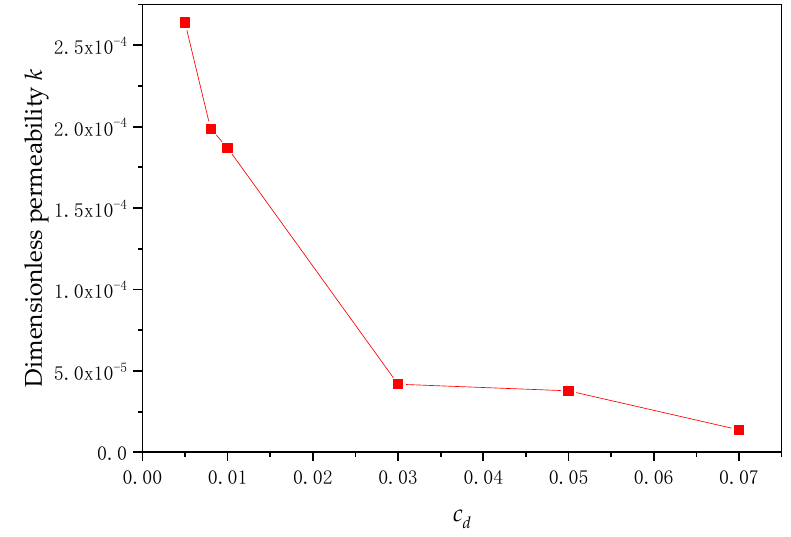
Figure 29. The relationship between growth core probability and dimensionless permeability of quartet structure generation set.